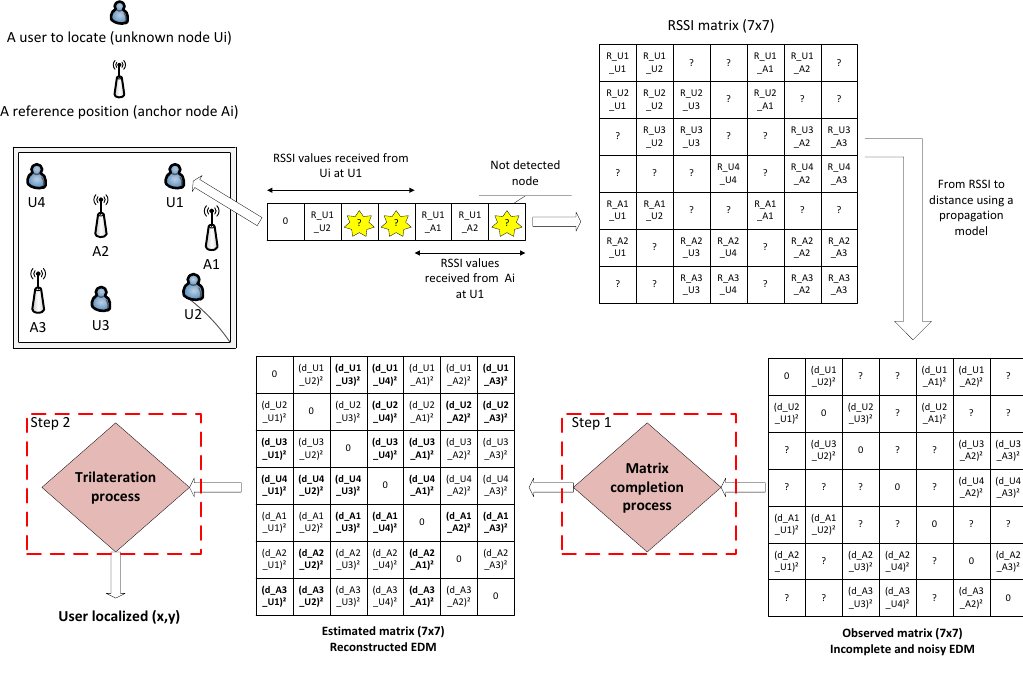
Figure 1. Algorithm details considering the sensor network consisting of seven sensor nodes from which three are